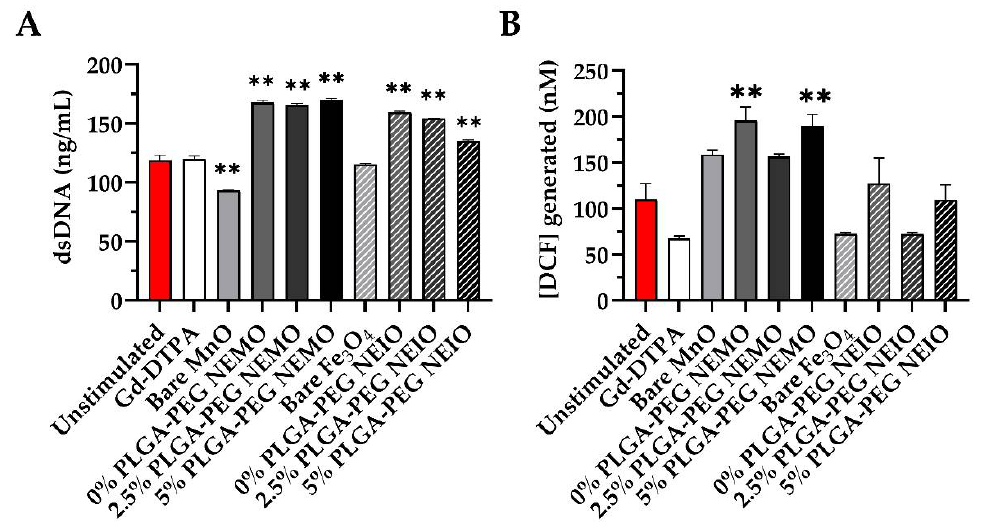
Figure 5. NEMO and NEIO particles both provoke neutrophil extracellular DNA release but only NEMO particles elevate ROS production. ( A ) Quant-iT ™ Picogreen ™ dsDNA assay was utilized to quantify the presence of cell-free dsDNA, which is indicative of NETosis, in each neutrophil sample’s supernatant following contrast agent exposure. dsDNA production was similar between the MnO and Fe 3 O 4 NP formulations, despite significantly higher NETosis produced by MnO NPs. ** indicates significance ( p < 0.01). The error bars represent standard error. ( B ) OxiSelect ™ In Vitro ROS/RNS assay was utilized to determine the relative difference in neutrophil oxidative stress in supernatants for each stimulation group; 2′, 7′-dichlorodihydrofluorescein (DCF) is the end product fluorescent indicator for total ROS/RNS levels in each sample. The 0% and 5% PLGA-PEG NEMO particles were the only groups to show enhanced relative ROS production. ** indicates significance ( p < 0.01). The error bars represent standard error.